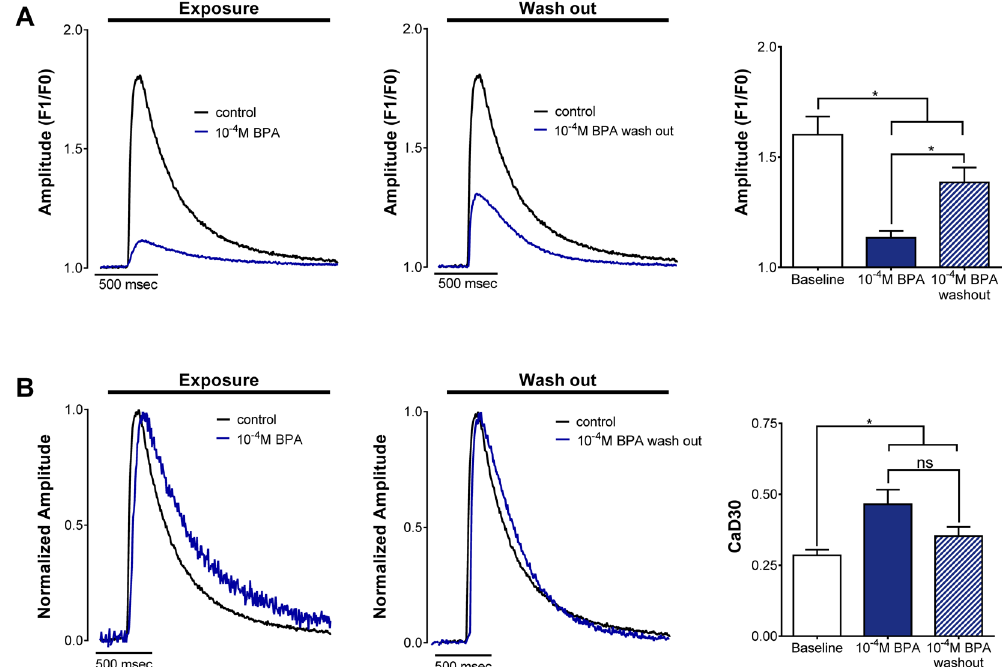
Figure 6. Reversibility of BPA-induced changes in calcium handling. ( A ) CaT amplitude is diminished following 15-min exposure to 10 − 4 M BPA (left panel); this effect is partially reversible when 10 − 4 M BPA is washed out (middle panel, right panel). ( B ) Normalized calcium signals shown prolonged CaT upstroke time and duration time following 15-min exposure to 10 − 4 M BPA (left panel); CaT duration effects are partially negated following 1-hr wash out. F1 = peak fluorescence amplitude, F0 = baseline fluorescence, ns = not significantly different, * p ≤ 0.05, n ≥